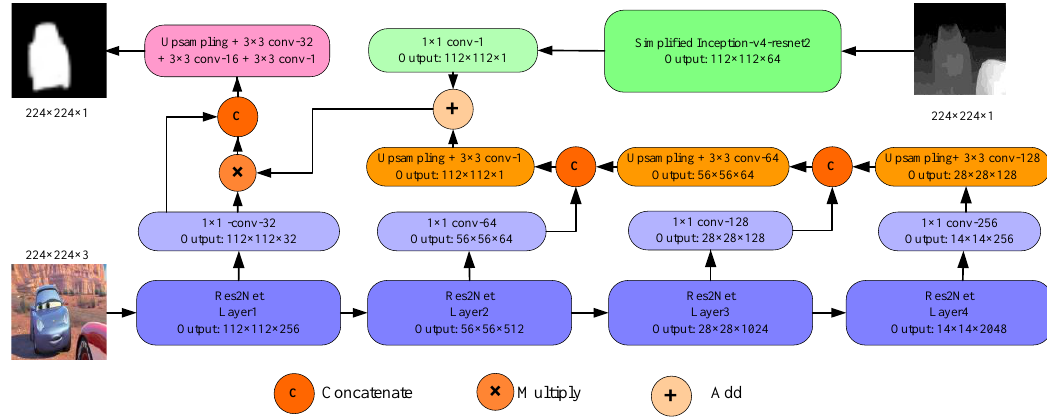
Figure 1. Framework of our HANet. The RGB-D imge is selected form Ref. [31].